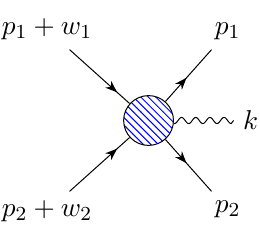
Figure 1 . The amplitude A (0) ( p 1 + w 1 ; p 2 + w 2 ! p 1 ; p 2 ; k ) appearing in the radiation kernel at leading